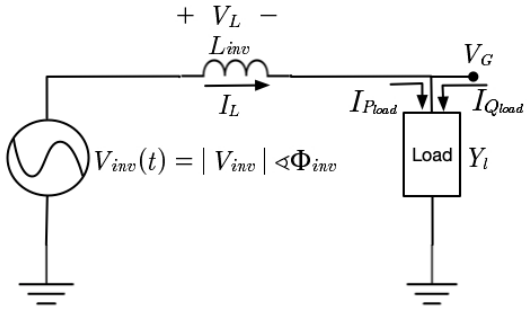
Figure 5. Circuit model in active power compensation